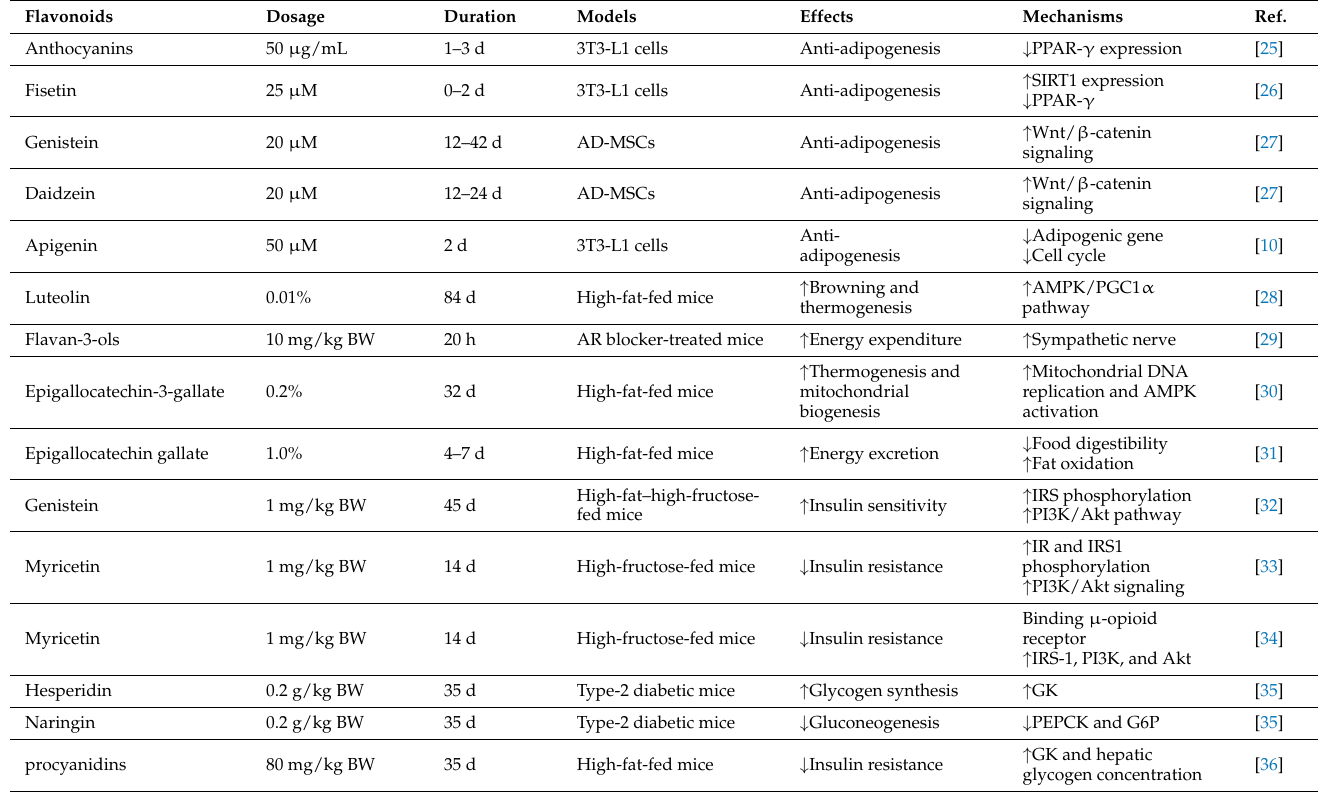
Table 1. Effects of flavonoids on obesity in experimental